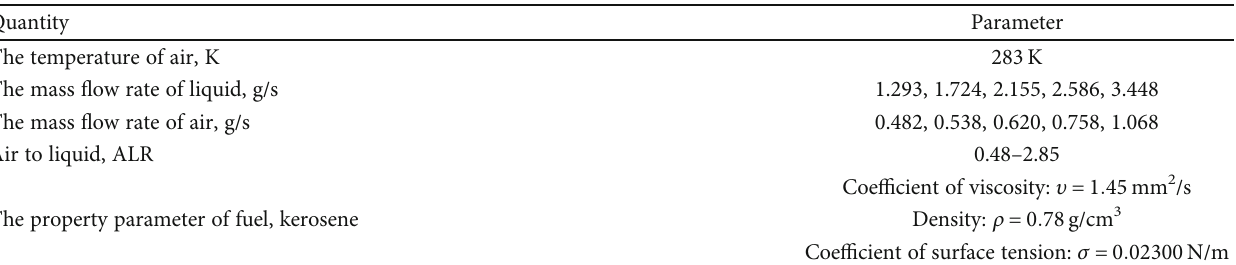
Table 2: The operating condition adopted in the